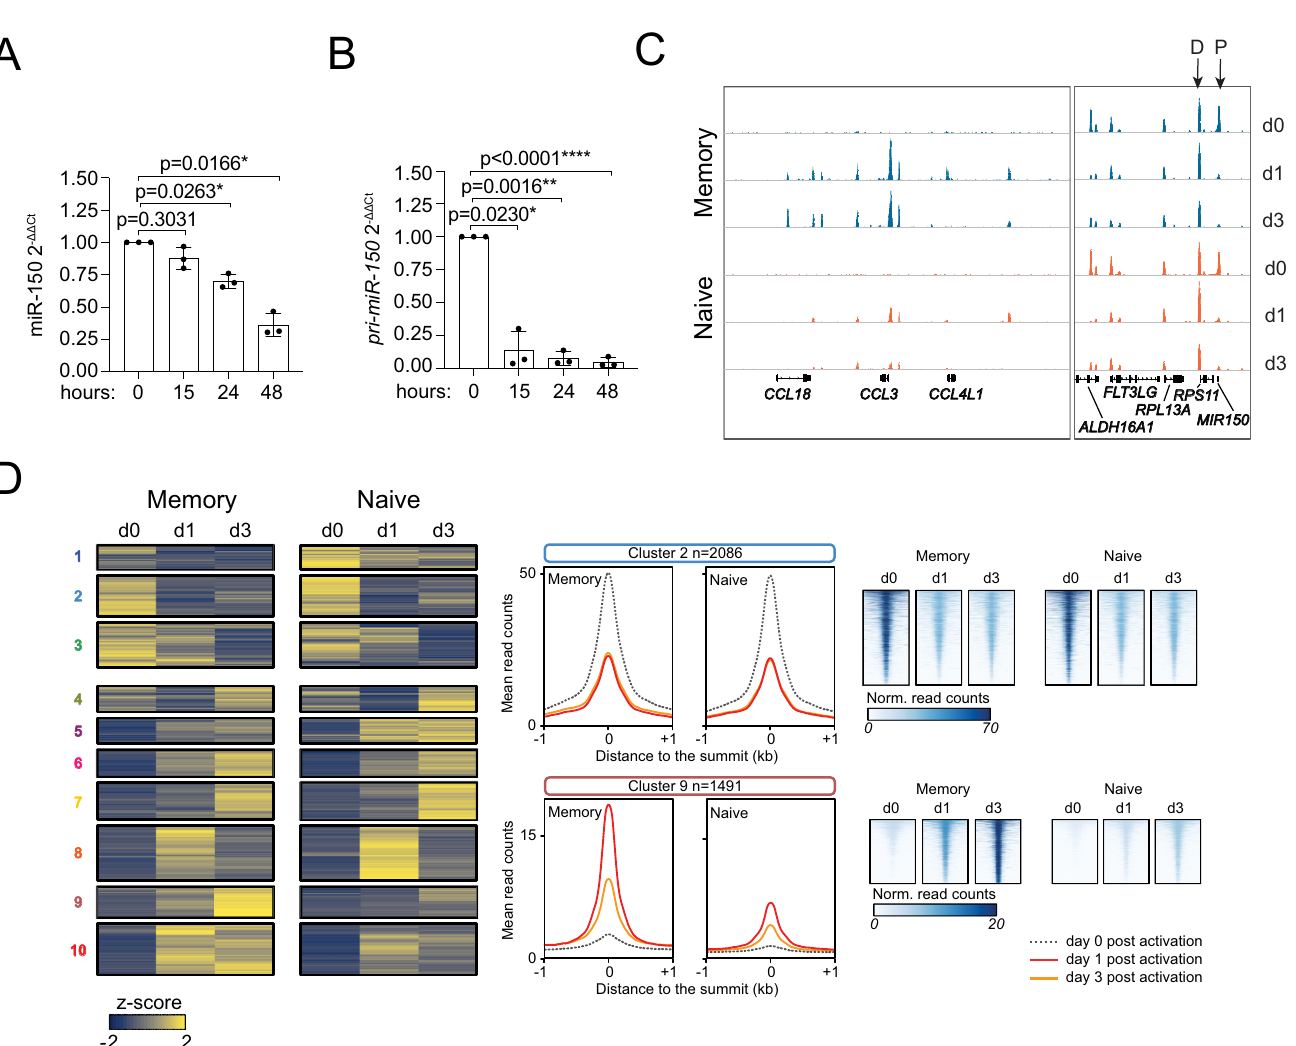
Fig 6. ATAC-seq analysis in human CD4 + T-cell subsets. (A) Memory T cells were sorted from peripheral blood and were either left resting or activated with plate-bound anti-CD3 and anti-CD28 antibodies for the indicated number of hours. Total RNA was extracted and miR-150 expression was measured by RT-qPCR. N = 3 independent donors (each dot represents one donor). Mean ± SD. One-way ANOVA. Underlying data can be found in S1 Data. (B) Same as (A), except that the expression of pri-miR-150 was measured. N = 3. Mean ± SD. One-way ANOVA. Underlying data can be found in S1 Data. (C) Naive and memory T cells were freshly isolated from 3 independent donors and were either left resting or were stimulated with anti-CD3 and anti-CD28 antibodies for 1 or 3 days, before tagmentation and sequencing for ATAC-seq analysis. Representative snapshots of the sequencing tracks. Arrows indicate the distal (D) and proximal (P) peaks relative to MIR150 . (D) Clustering analysis including all ATAC-seq peaks that were significantly affected after 24 hours or 72 hours of activation in either naive or memory T cells, with different representations of cluster 2 and 9 (middle and right panels). ATAC-seq, assay for transposase accessible chromatin and sequencing; RT-qPCR, reverse transcription quantitative